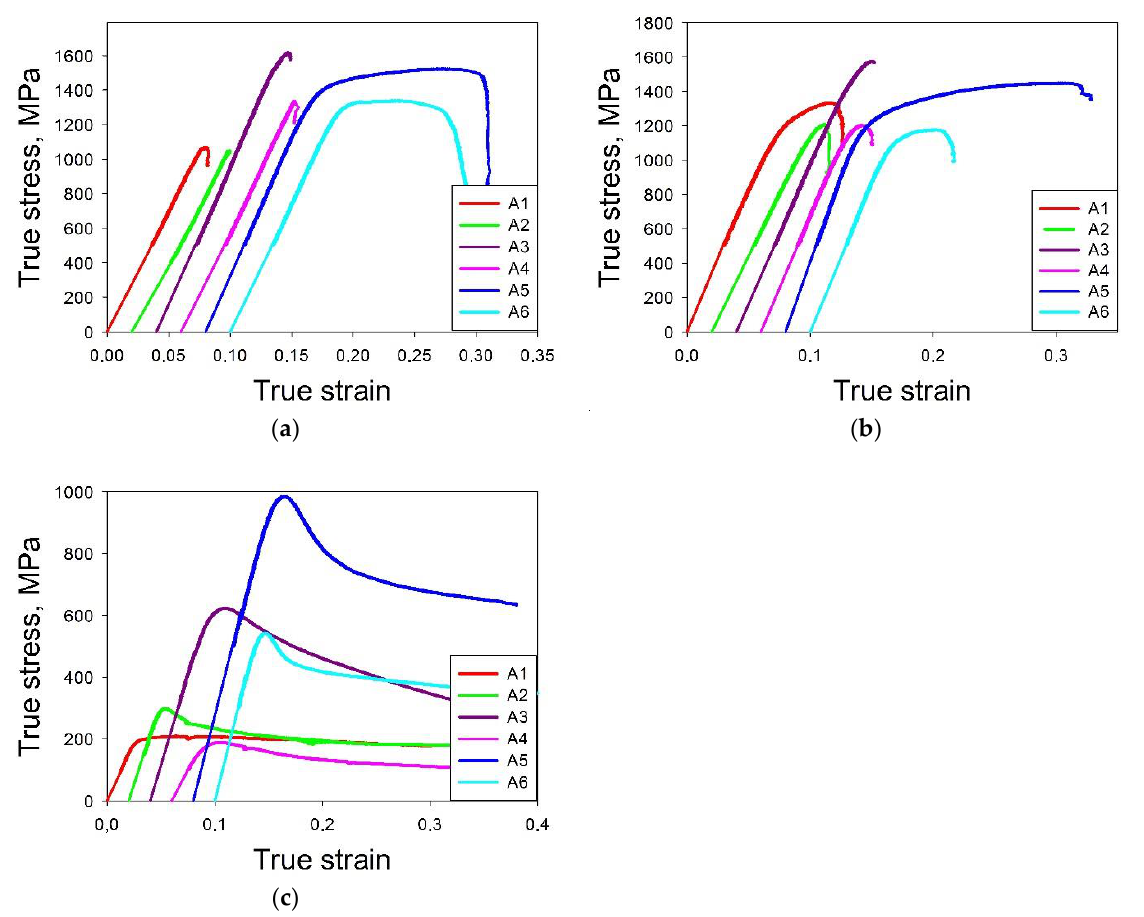
Figure 11. Compression true stress–true strain curves for model alloys at 20 ◦ C ( a ), 600 ◦ C ( b ) and 800 ◦ C ( c ). The experimental and predicted by machine learning method yield strength values are shown in Table 4 and Figure 12. The surrogate model results were in good prediction accuracy at 20 ◦ C and 600 ◦ C; at 800 ◦ C the prediction error was more pronounced. The mean prediction error is 7% at 20 ◦ C and 12% at 600 ◦ C, which is comparable to the accuracy of such predictive systems. Accuracy of prediction hardness for Al-Co-Cr-Cu- Fe-Ni system near 80% [47,71]. Li et al. [49] had a mean error between molecular dynamic simulation of tensile and strength predicted by machine learning less than 2%. At 800 ◦